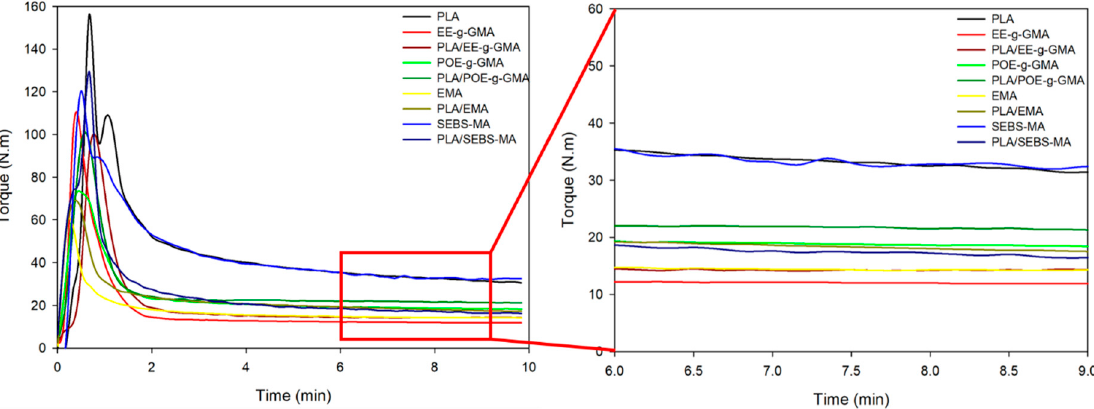
Figure 2. Torque versus time curves of pure PLA, impact modifiers and blends (70/30% by mass).